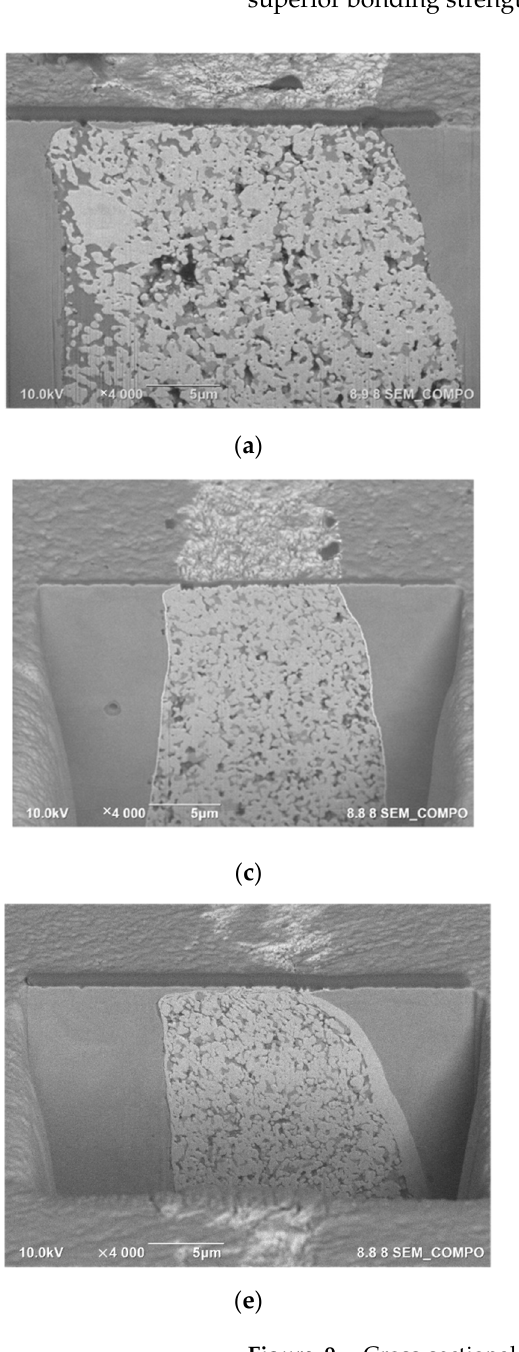
Figure 9. Cross-sectional LNCP(EC) joint microstructure with different substrates: ( a , b ) Cu, ( c , d ) Ni/Au and ( e , f ) Ag.